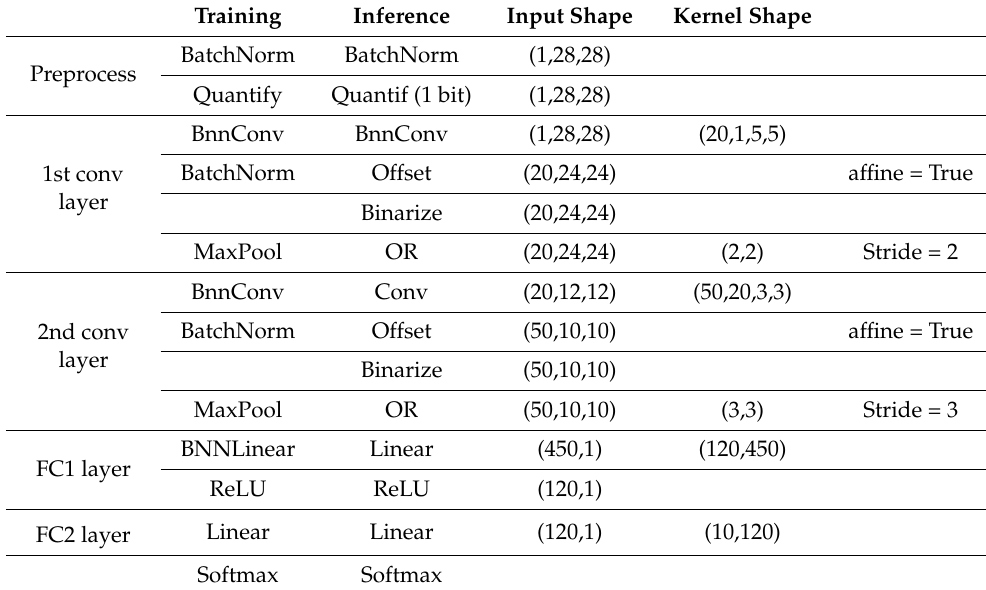
Table 1. Parameter configuration of the model I network.